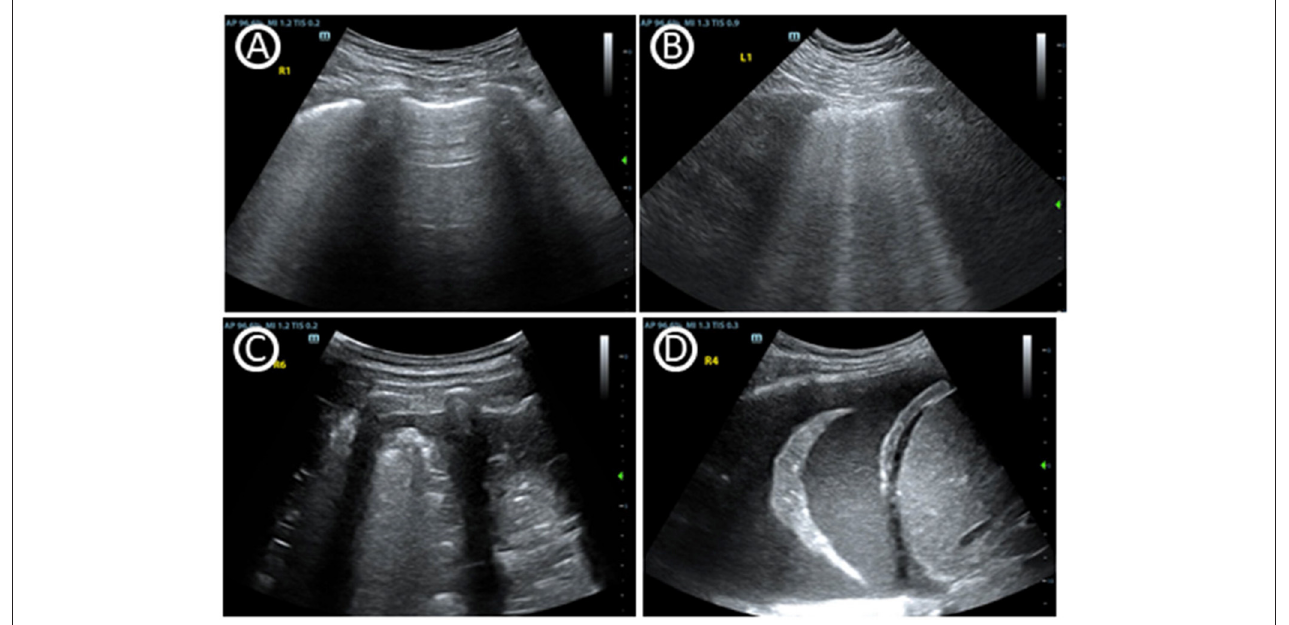
FIGURE 2 | Basic signs of lung ultrasound. (A) A-lines, horizontal reverberation artifacts at a regular distance indicate a high gas–volume ratio below the parietal pleura. (B) Multiple B lines, are vertical artifacts deriving from the pleural line, moving synchronously with lung sliding, usually reaching the bottom of the screen and erasing A-lines. (C) Tissue-like pattern identifies lobar consolidation. (D) Pleural effusion.